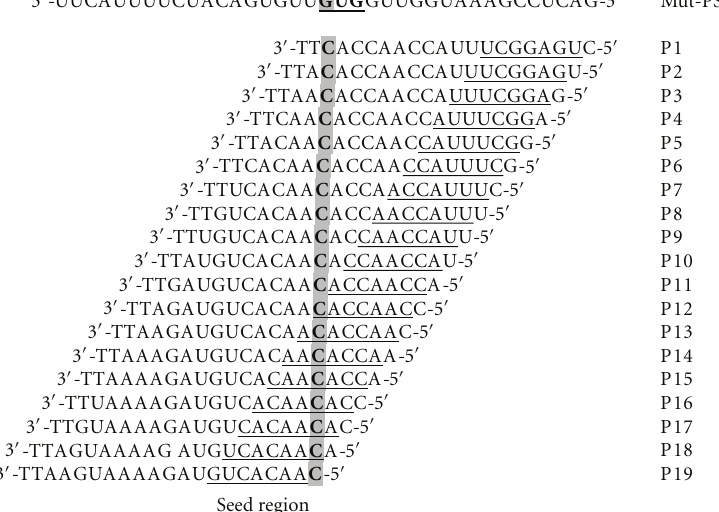
Figure 3: The sequences of the antisense strands of siRNAs used in studies. The guide strand of each siRNA is fully complementary to the mutant (C → G) PSEN1 transcript and it has one mismatch (C:C) in respect to the wild type gene. The region between 2nd to 8th nucleotide, counted from the 5 (cid:3) -end of the antisense strand of siRNA is known as the seed region.